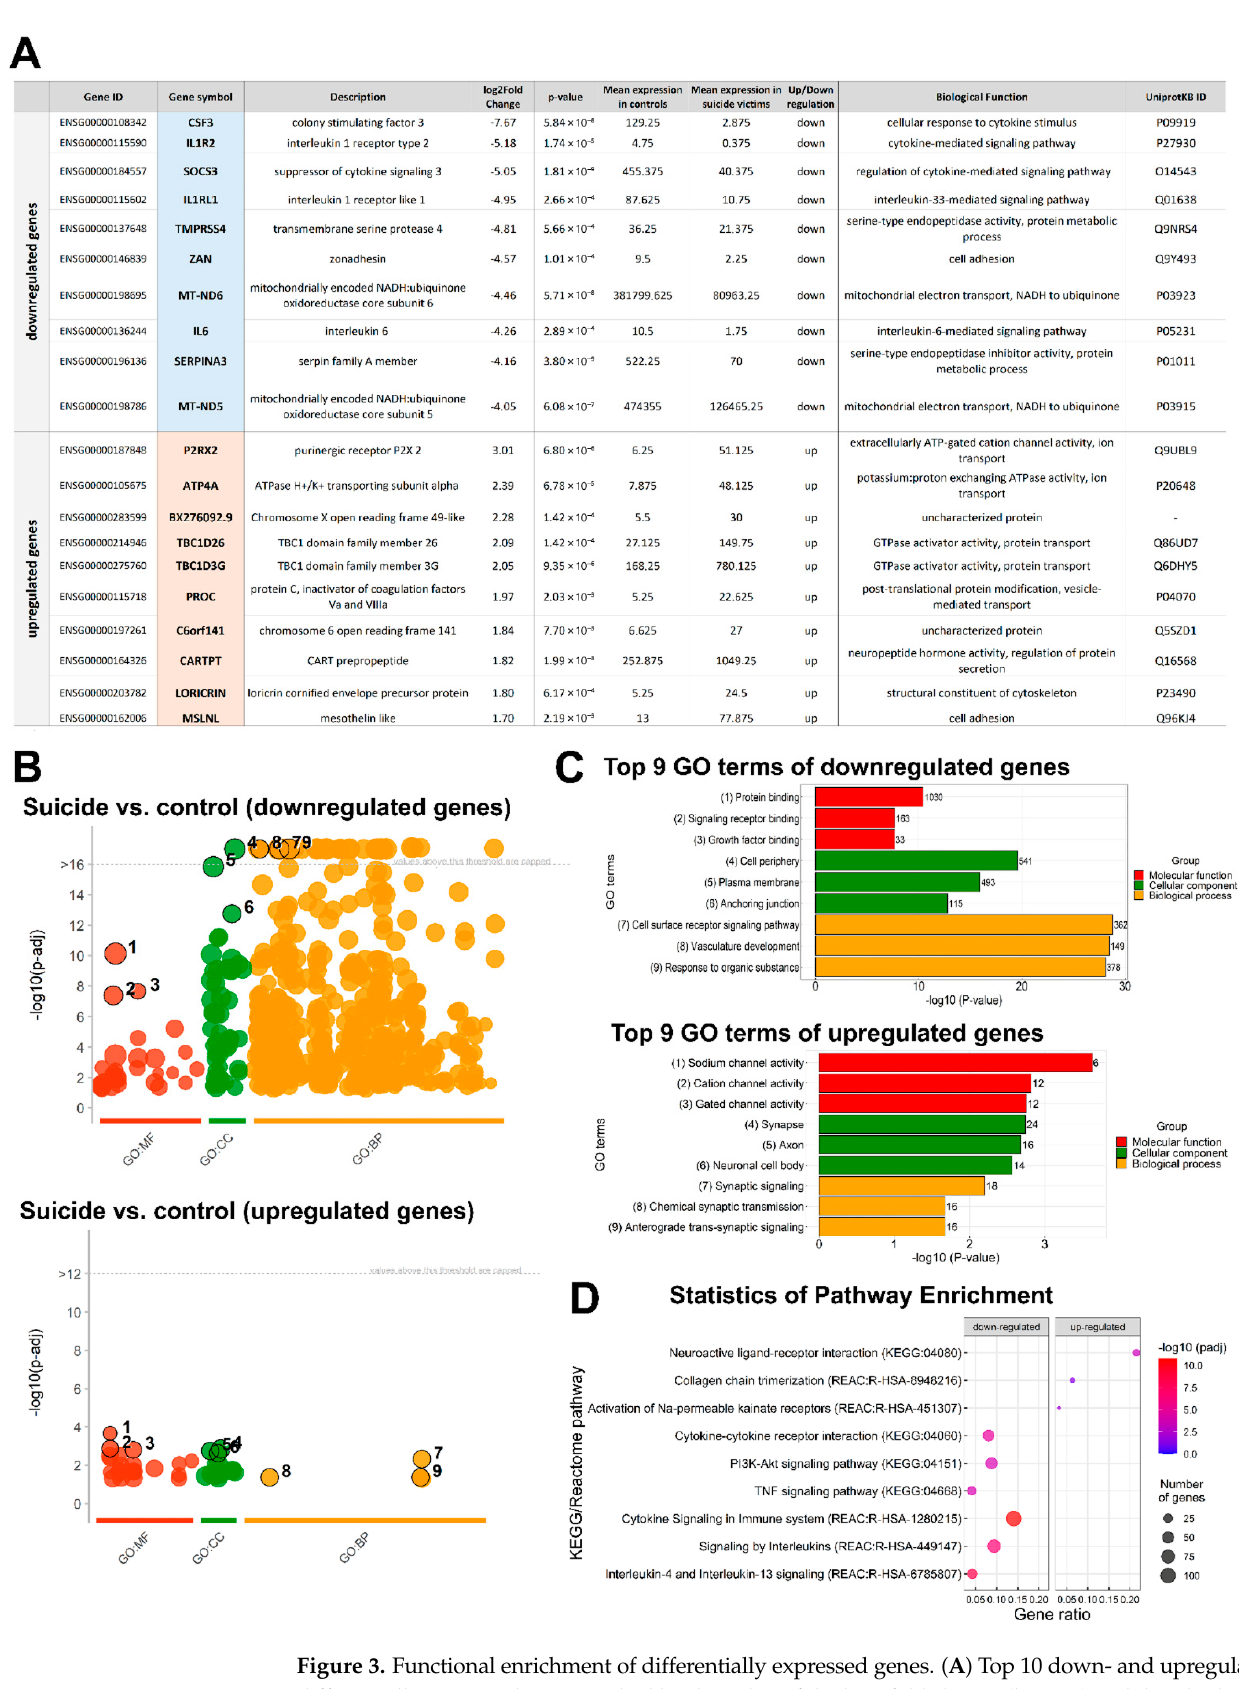
Figure 3. Functional enrichment of differentially expressed genes. ( A ) Top 10 down- and upregulated differentially expressed genes ranked by the value of the log2 fold change (log2FC) and their biological functions. ( B ) Manhattan plot shows the enrichment results of down- and upregulated genes. The